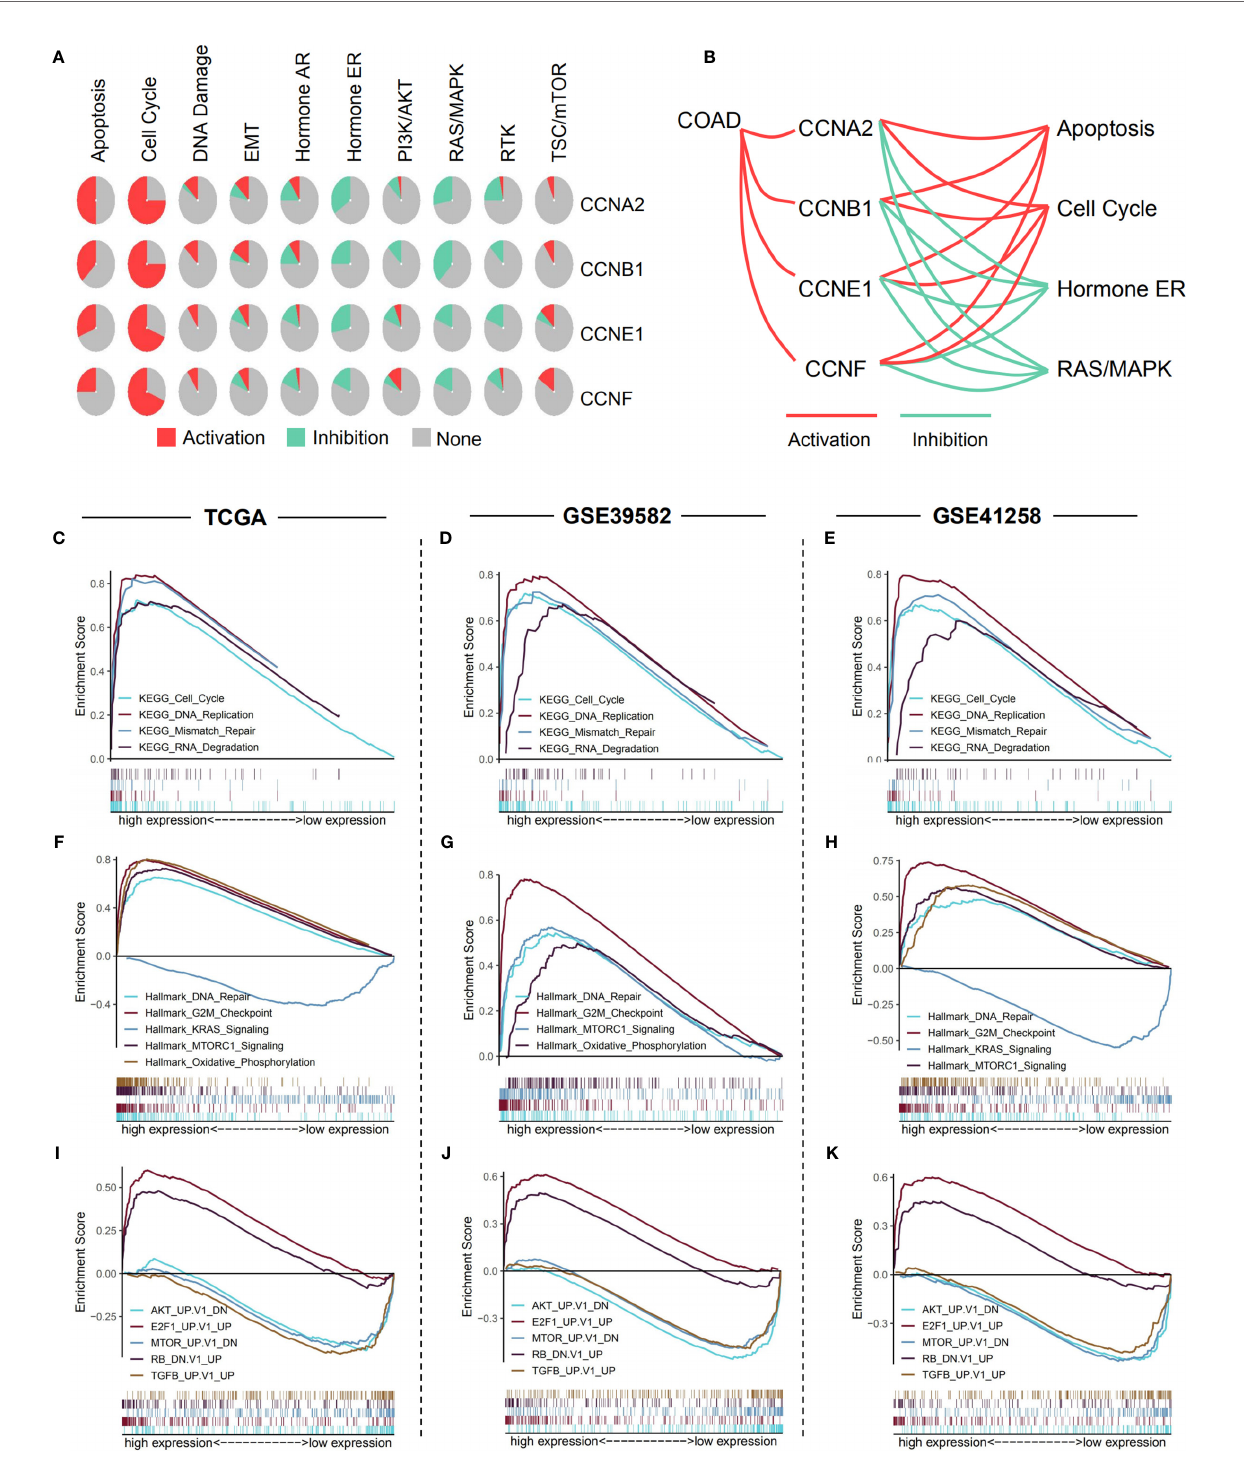
FIGURE 10 | Pathway analysis of the four signi fi cant cyclin genes. (A) Pathway activity of the four genes from GSCA. (B) CCNA2 , CCNB1 , CCNE1 , and CCNF might strongly activate the cell cycle and apoptosis as well as inhibit hormone ER and RAS/MAPK pathways. (C – K) Enriched gene sets between high and low expression sample groups based on the CCNB1 gene levels in the three datasets using GSEA. Reference gene sets were KEGG (C – E) , Hallmark (F – H) , and oncogenic signatures gene sets (I – K)